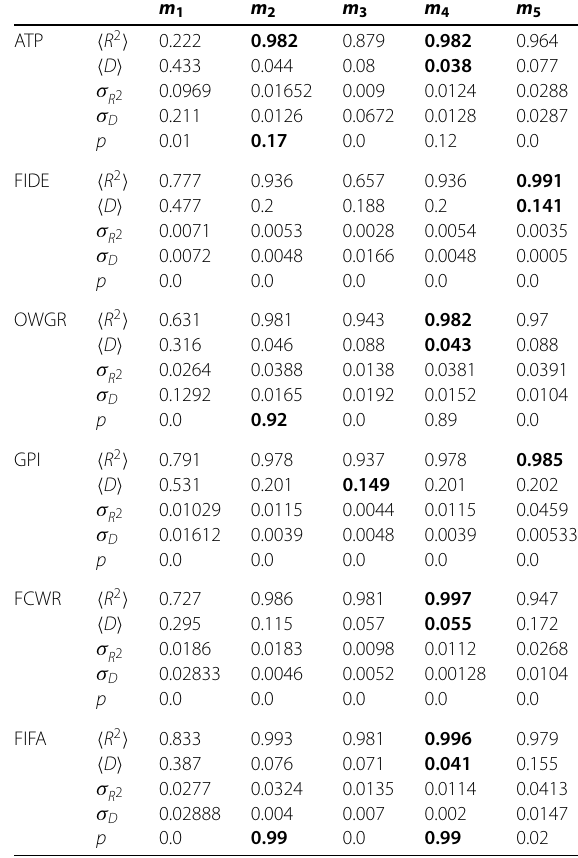
Tablelistingmeanvalues (cid:5) R 2 (cid:6) and (cid:5) D (cid:6) (andtheirassociatedstandarddeviations σ D and σ available, forthefittingprocessbetween thesixsportsandfivetheoreticalrankdistributionsused here.Wealsoinclude values oftheKolmogorov-Smirnovindex p forthesingletimesliceofFigure1.Higher (cid:5) R 2 (cid:6) andlower (cid:5) D (cid:6) implybetterfits. aresmall, thefitsshowninFigure1arerepresentativeoftheentiredatasets.Thebestfitsforeachsportare Since σ D and σ R 2